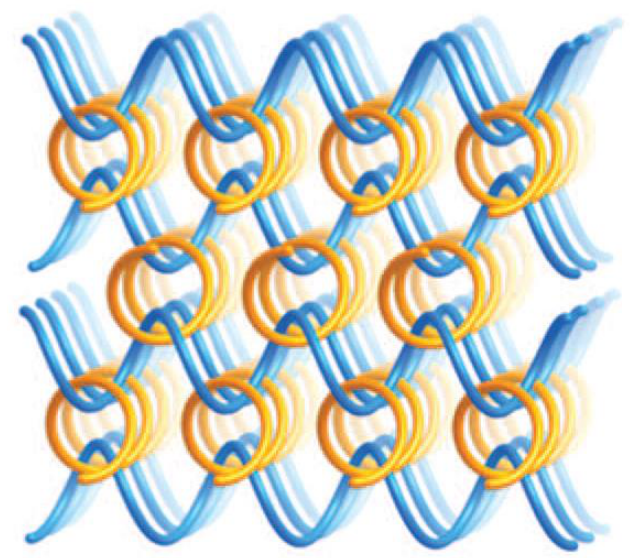
Figure 7. Schematic representation of weaving threads in three-dimension [25].